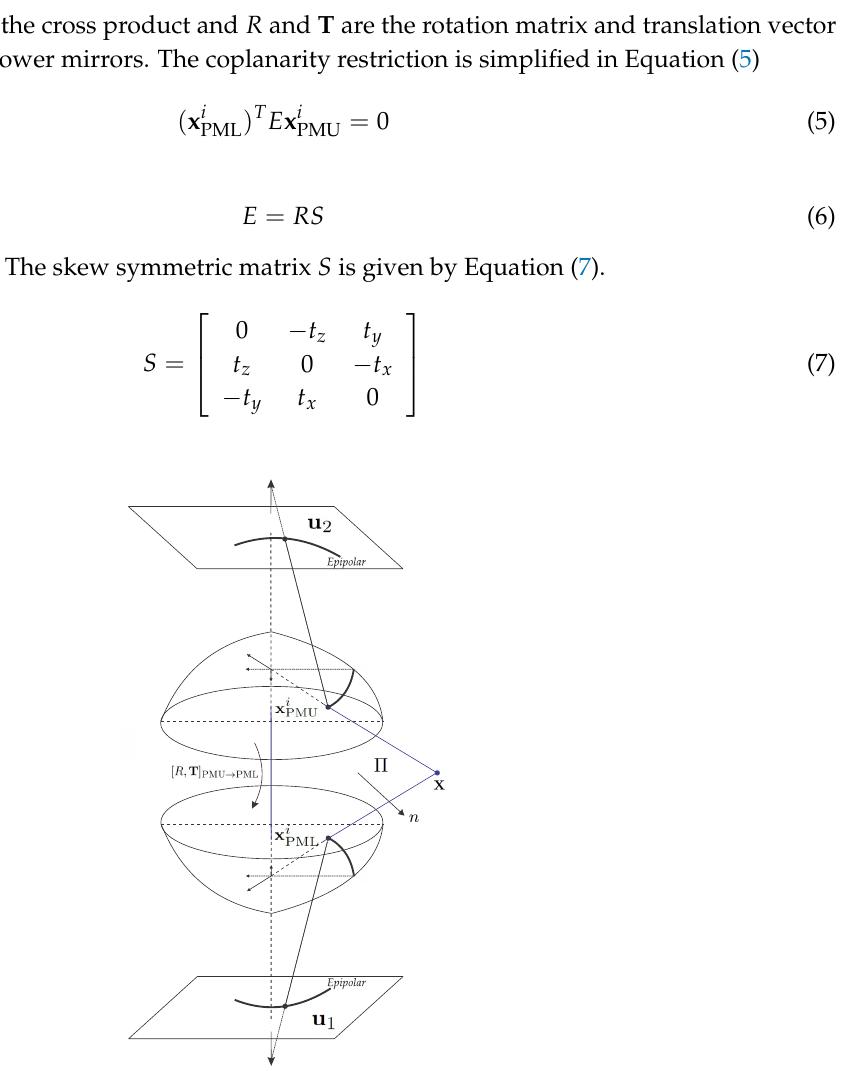
Figure 3. Epipolar geometry between two catadioptric cameras with parabolic mirrors. R is the rotation matrix and T is the translation vector, between the upper and lower mirrors (PMU → PML) expressed as a skew symmetric matrix. Π is the epipolar